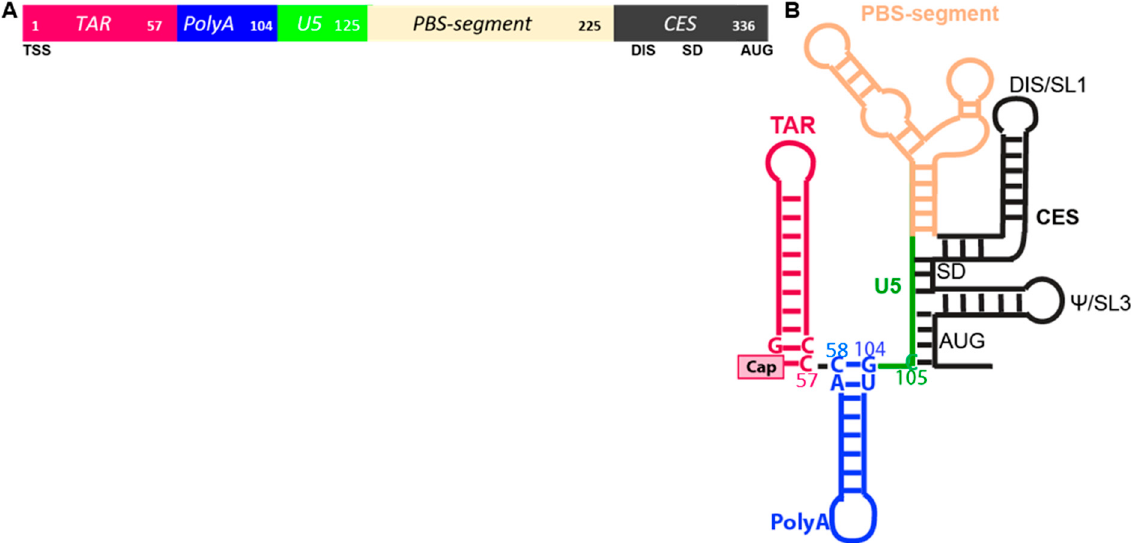
Figure 1. Motifs within the HIV 5 ′ -untranslated region (UTR). ( A ) Linear arrangement of TAR, Tat trans-activation responsive element, magenta; PolyA, blue; U5, Unique 5 ′ region, green; PBS-segment segment containing the primer binding site (PBS), tan; CES, core encapsidation signal, black, Numbers indicate position in the 5 ′ -UTR. Lower line: TSS, transcription start site; DIS, dimerization initiation site inclusive of SL1; SD, splice donor; AUG, gag start codon. ( B ) Secondary structure model. Select nucleotides pairings coordinate TAR-PolyA stem loops and PolyA-U5 stem.